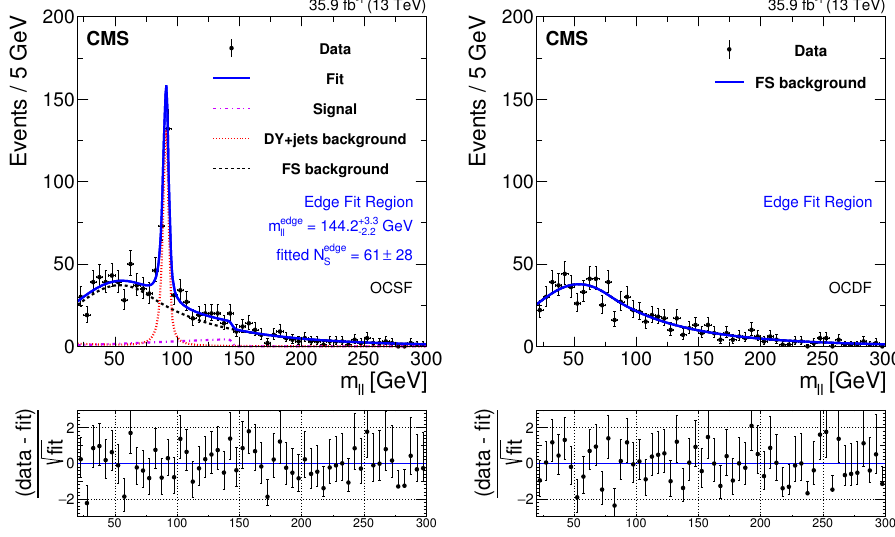
Figure 6 . Fit of the dilepton mass distributions to the signal-plus-background hypothesis in the \Edge (cid:12)t" SR from table 1, projected on the same-(cid:13)avor (left) and di(cid:11)erent-(cid:13)avor (right) event samples. The (cid:12)t shape is shown as a solid blue line. The individual (cid:12)t components are indicated by dashed and dotted lines. The FS background is shown with a black dashed line. The DY+jets background is displayed with a red dotted line. The extracted signal component is displayed with a purple dash-dotted line. The lower panel in each plot shows the di(cid:11)erence between the observation and the (cid:12)t, divided by the square root of the number of (cid:12)tted events.